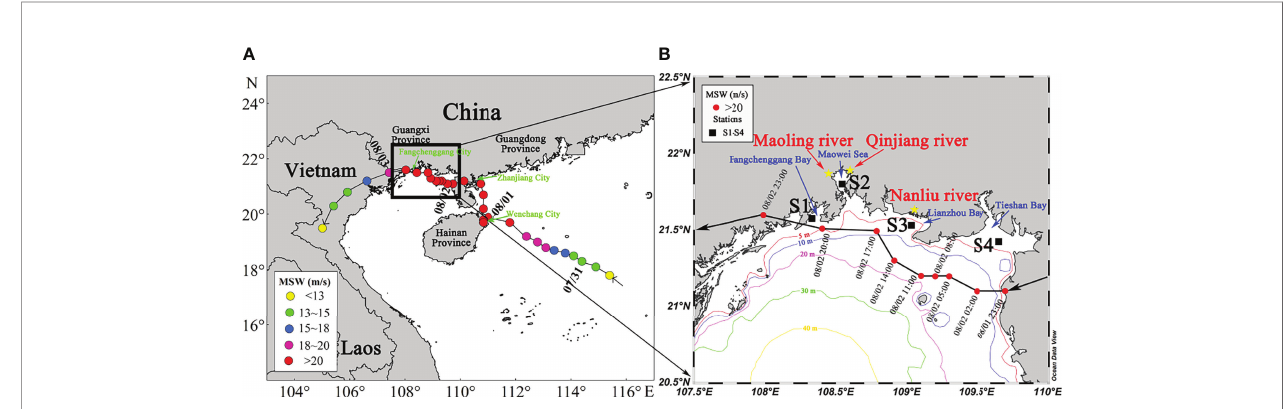
FIGURE 1 | (A) Track and intensity of TS Wipha in the northwestern SCS. (B) Depth map of the northern Beibu Gulf in the study area (20.5° N-22.5° N, 117.5° E-110° E). Black squares are the observational stations (S1-S4). Yellow stars mark the river estuaries. MSW: maximum sustained wind speed. Dates are given as